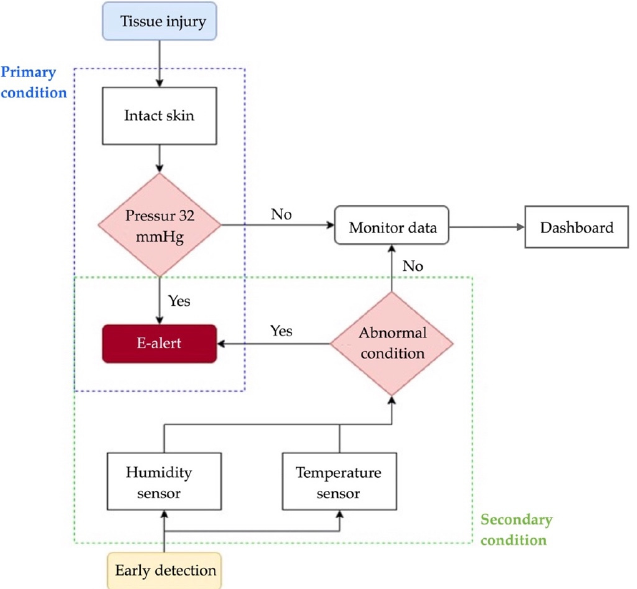
Figure 3. Diagram of the pressure sensors.